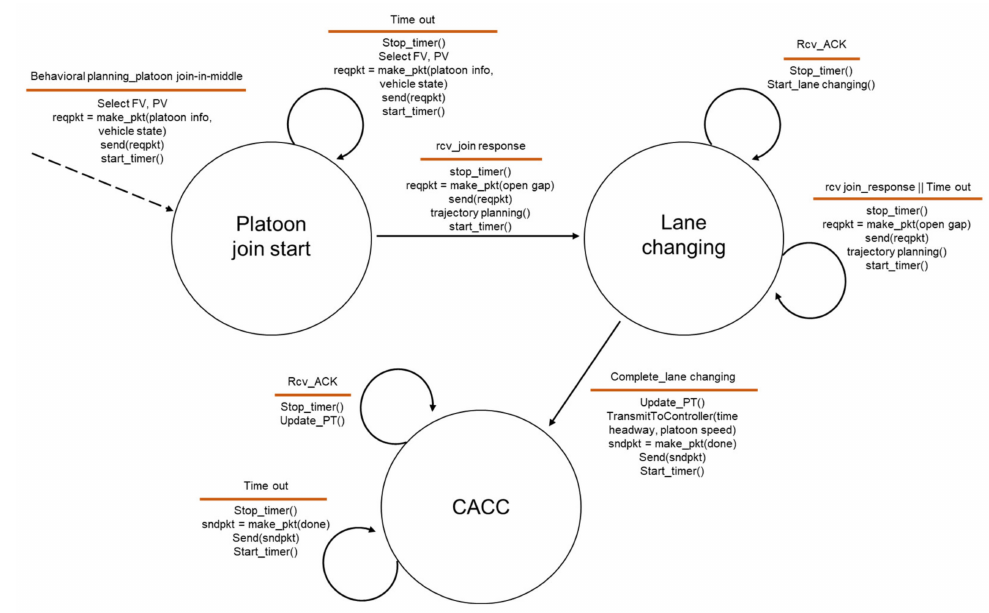
Figure 4. State machine of joining